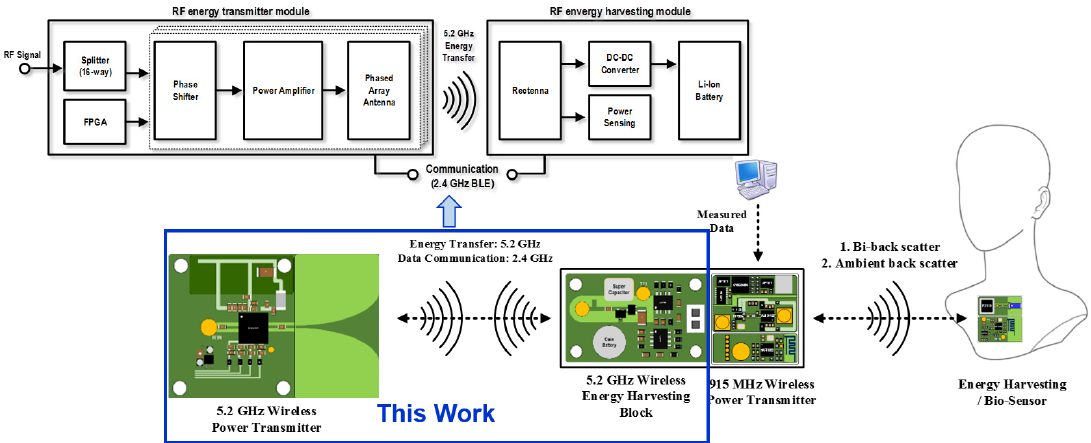
Figure 1. Top block diagram of the radio frequency (RF) energy harvester. Reprint with permission [4775431338148]; 2020, IEEE.